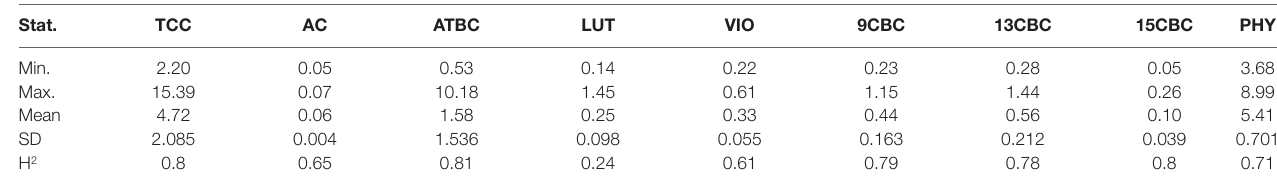
TABle 2 | Summary statistics and heritability of total carotenoid content (TCC), all-trans β-carotene (ATBC), violaxanthin (VIO), lutein (LUT), 15-cis beta-carotene (15CBC), 13-cis beta-carotene (13CBC), alpha-carotene (AC), 9-cis beta-carotene (9CBC), and phytoene (PHY) from cassava roots.